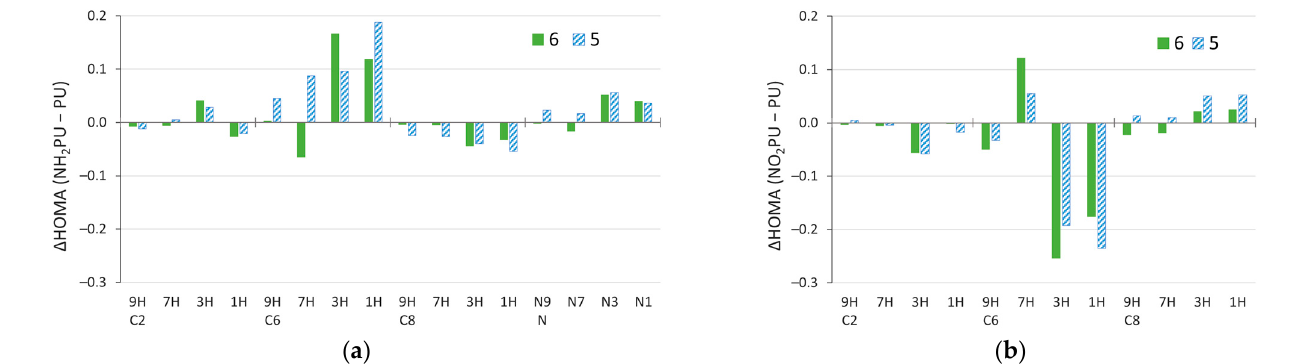
Figure 7. Changes in HOMA index due to substitution, Δ HOMA, calculated by subtracting the value for unsubstituted purine (PU) from the value for substituted purine (NH 2 PU or NO 2 PU). Data for the ( a ) amino and, for comparison, ( b ) nitro derivatives [59].